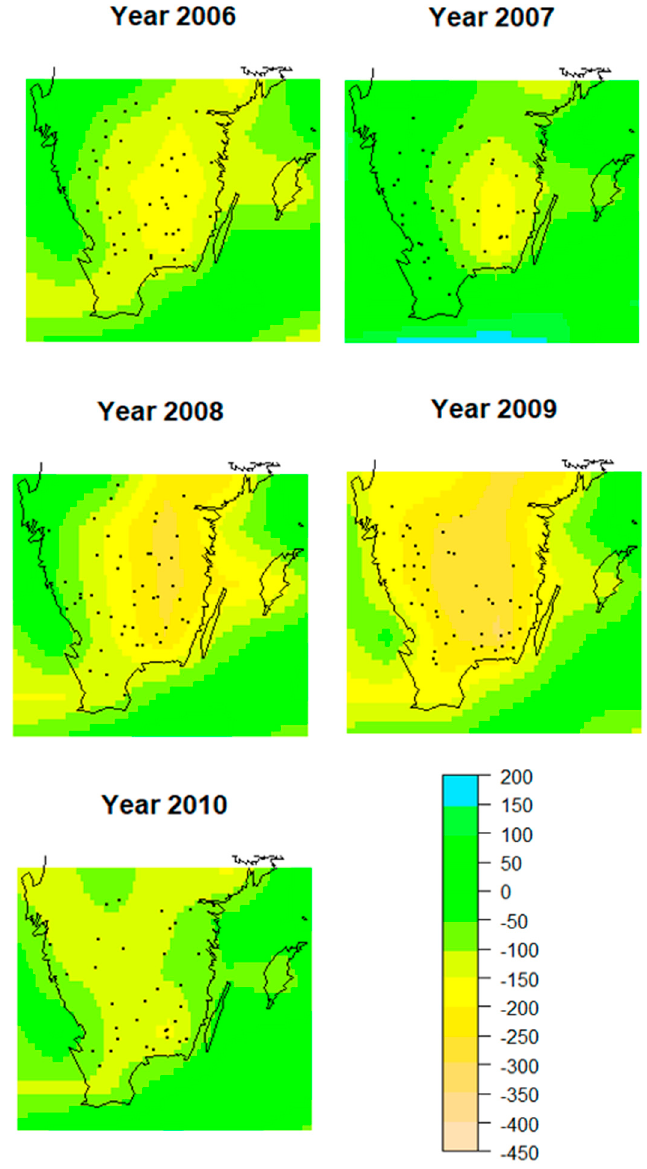
Figure 3. Accumulated available water (mm) in the years 2006–2010 and geographic locations of the clearcuts included in the re-inventory marked in planting years.